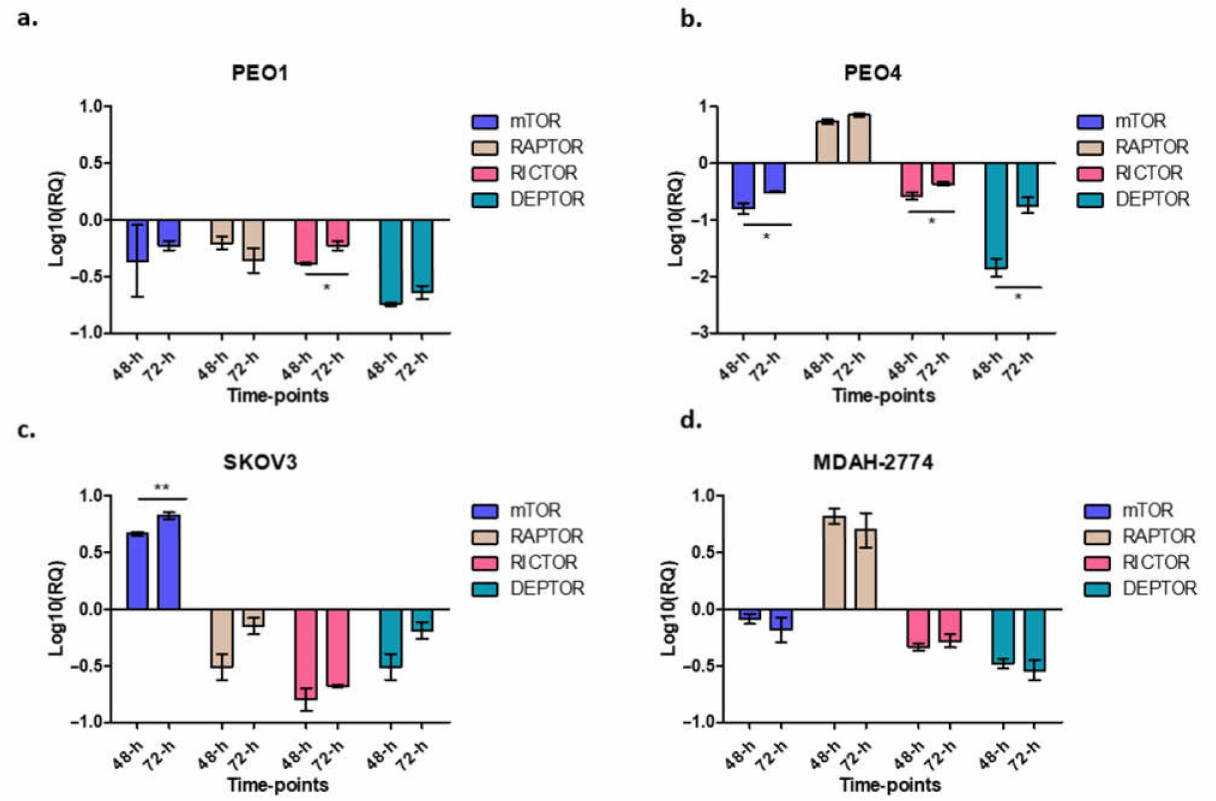
Figure 5. The figure represents the expression of different genes after rucaparib treatment in different time-points. Cells were treated with 10 µ M rucaparib as single agents. Cells were harvested 48-h and 72-h after 10 µ M rucaparib exposure. PEO1: RICTOR: * p = 0.0194 (panel a ); PEO4: mTOR: * p = 0.0447, RICTOR: * p = 0.0322, DEPTOR: * p = 0.0136, (panel b ); SKOV3: mTOR: ** p = 0.0092 (panel c ), and no significant changes observed in MDAH-2774 (panel d